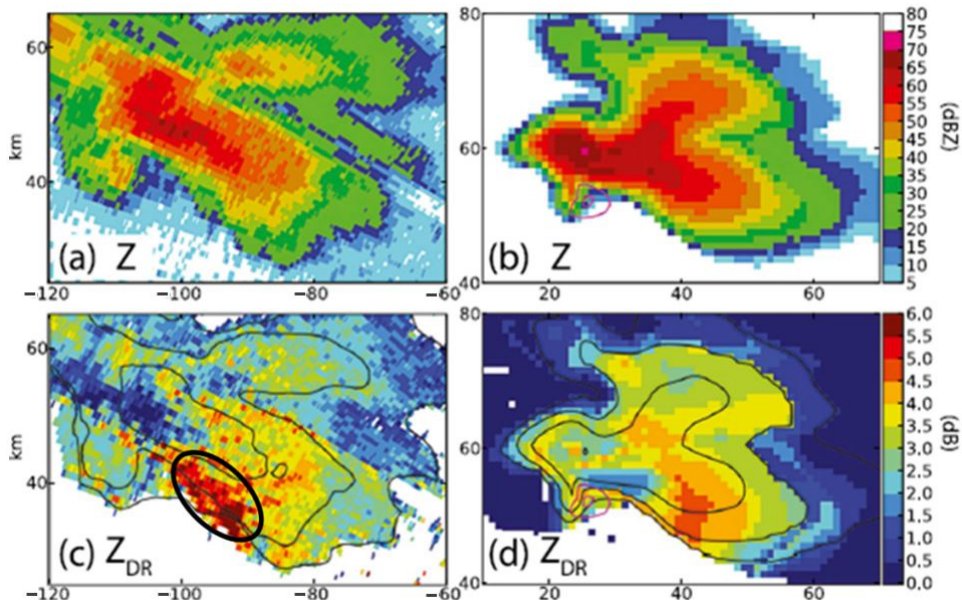
Figure 12. Observed (left panels a , c ) and simulated (right panels b , d ) fields of Z and Z DR near the surface of the 1 June 2008 Oklahoma nontornadic supercell. Overlaid are the reflectivity contours in 20-dBZ increments. The Z DR arc in the southern part of the forward flank downdraft is enclosed in the black oval. Adapted from Dawson et al. [64]. Used with permission from American Meteorological Society.